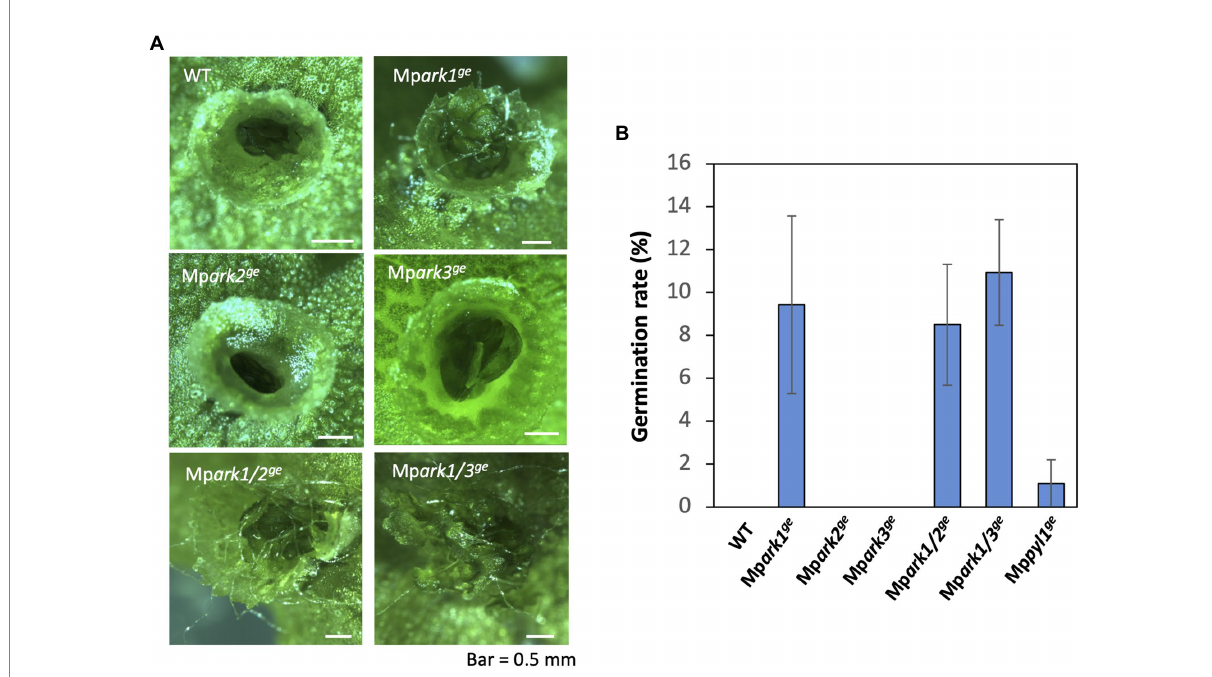
FIGURE 3 Comparison of dormancy of gemmae in gemma cups. (A) Appearance of gemmae in a gemma cup of WT and the B3-Raf genome-editing lines of M. polymorpha . Germination of rhizoids was frequently observed in gemmae of Mp ark1 ge , Mp ark1/2 ge , and Mp ark1/3 ge lines while gemmae of WT and Mp ark2 ge and Mp ark3 ge remained dormant within the gemma cup. (B) Germination rate of gemmae in gemma cup of WT and genome editing lines. Gemmae isolated from a gemma cup located at the most basal position in the thallus were used for analysis. Germination of rhizoids from gemmae was analyzed by staining with propidium iodide, and the percentages of gemmae growing rhizoids were plotted in histograms. The experiment was carried out on a date different from that shown in Supplementary Figure S4. Error bars indicate +/ − SE of the mean ( n =